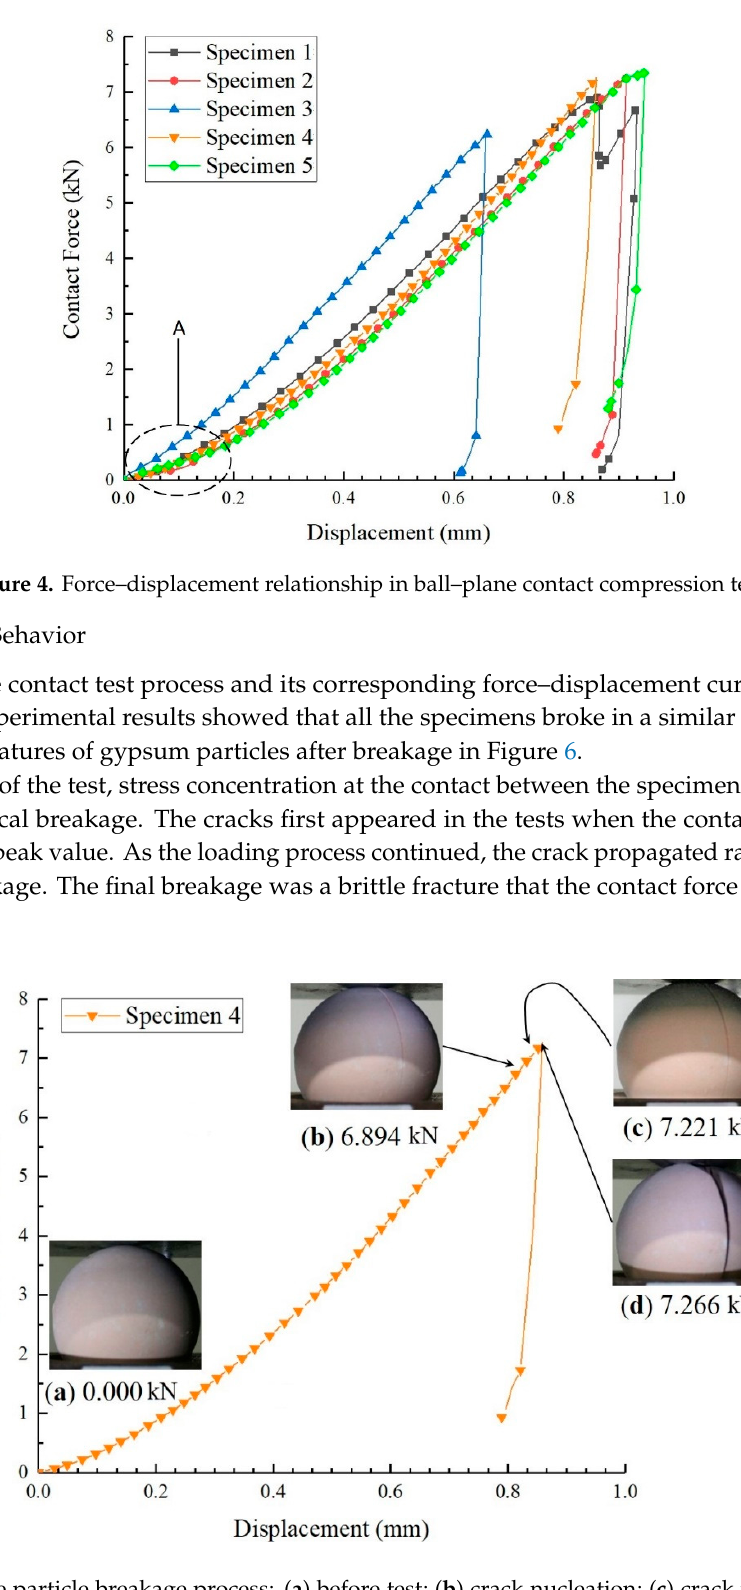
Figure 5. The particle breakage process: ( a ) before test; ( b ) crack nucleation; ( c ) crack propagation; and ( d ) particle breakage.